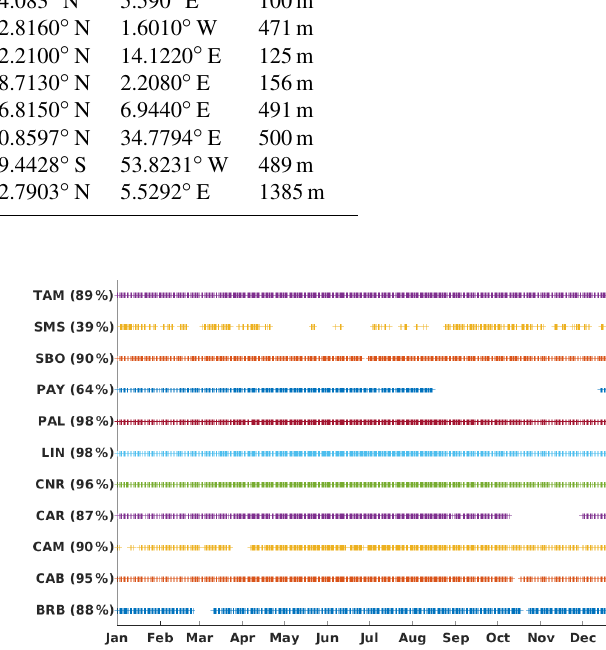
Figure 5. Time series used for the 15min mean statistics between satellite estimates and quality-checked BSRN measurements during the year 2011. In parentheses: percentage of data